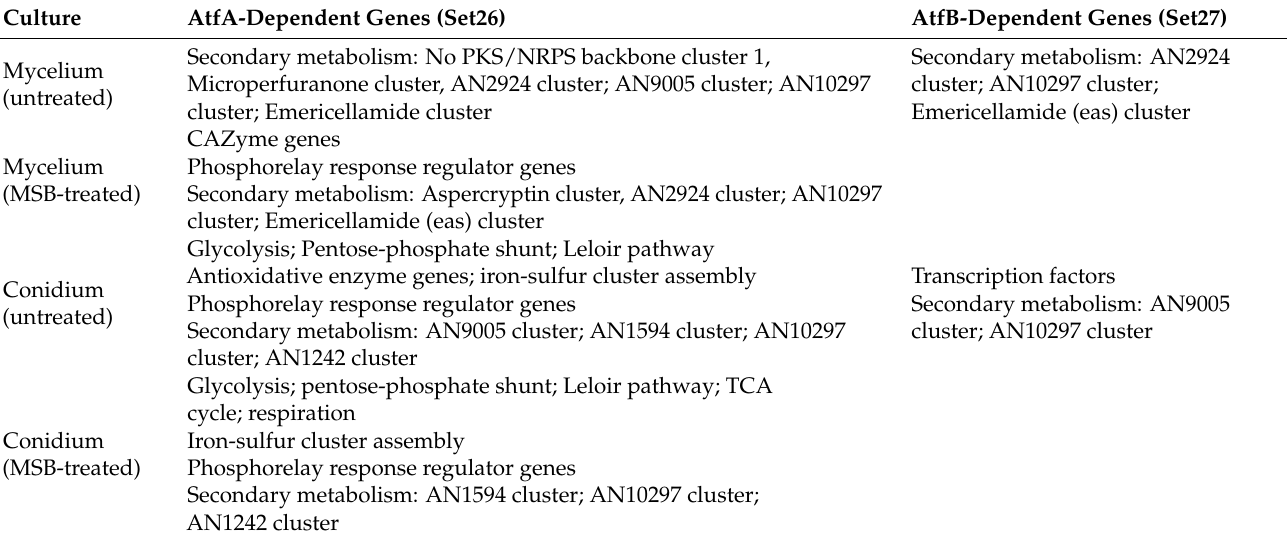
Table 4. Selected gene groups significantly enriched (Fisher’s exact test; p < 0.05) in the AtfA- and AtfB-dependent gene sets. The full list is available in Table